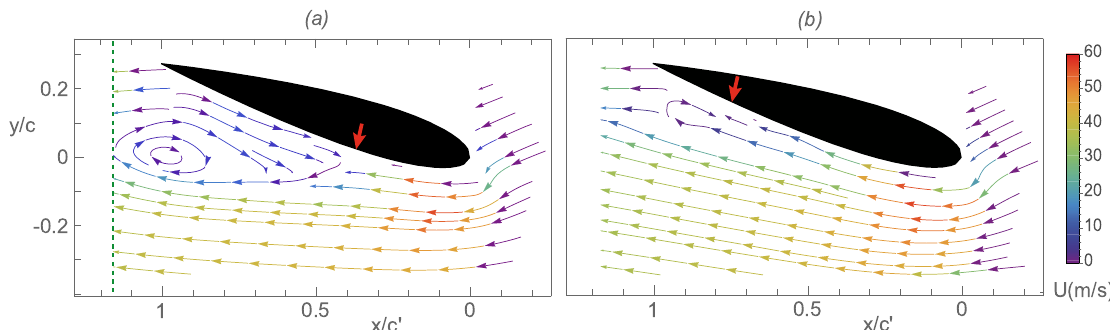
Figure 8. ( a ) Plasma-off and ( b ) plasma-on flow field at T A for α = 14.5 ◦ and U ∞ = 20 m/s: The dashed line in panel a marks the position of the cross-wake velocity profiles presented in Figure 9.